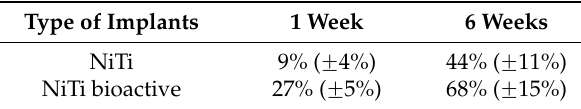
Table 2. Bone index contact after one and six weeks of implantation (columns) in percent.